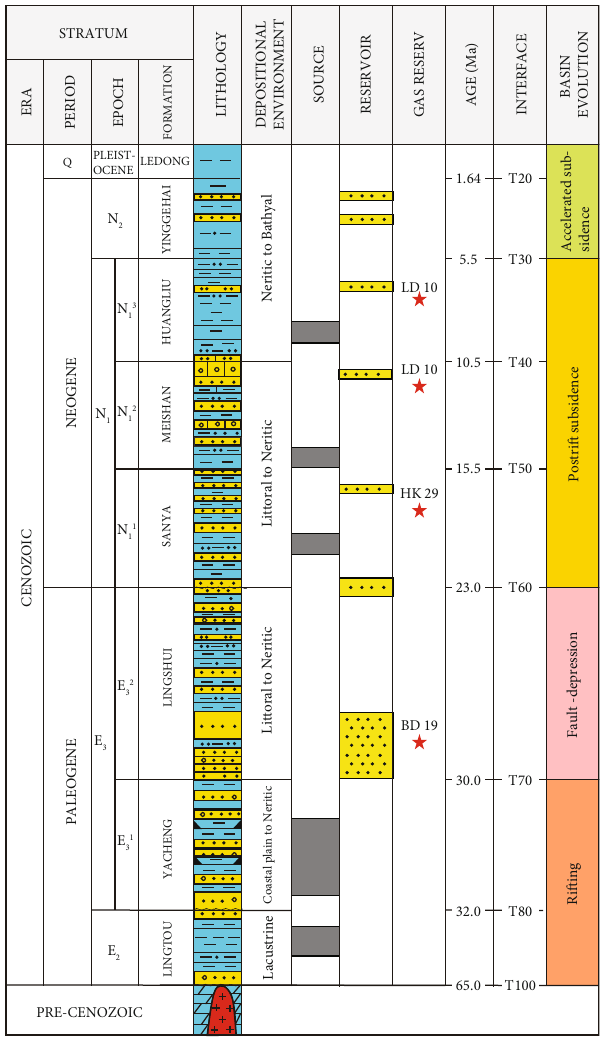
Figure 3: Generalized stratigraphic column of the Yinggehai and Qiongdongnan Basins